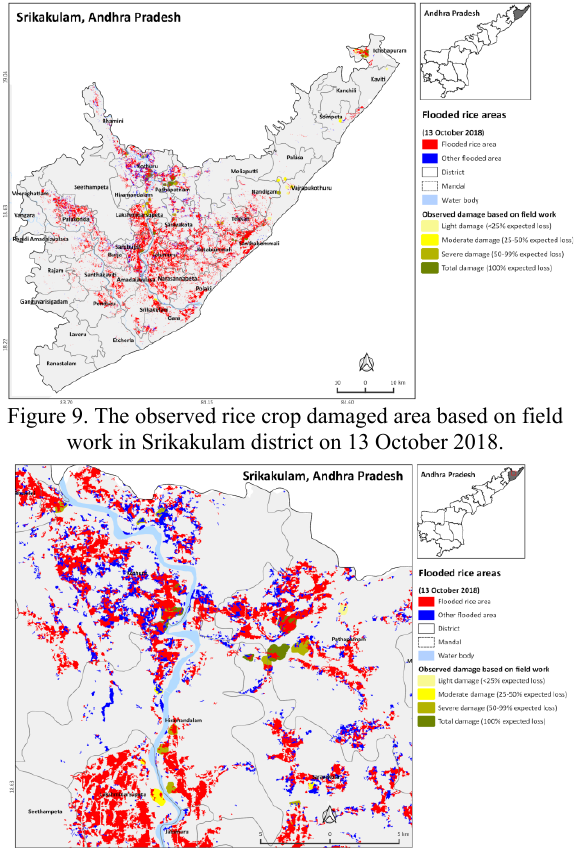
Figure 10. The observed rice crop damaged area in Jalumuru and Lakshminarsupeta mandals on 13 October